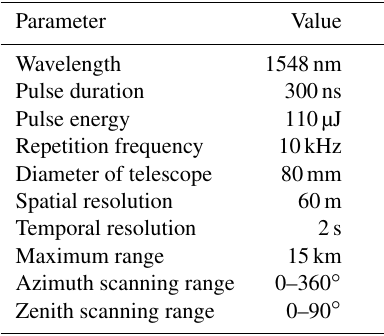
Table 1. Key parameters of the